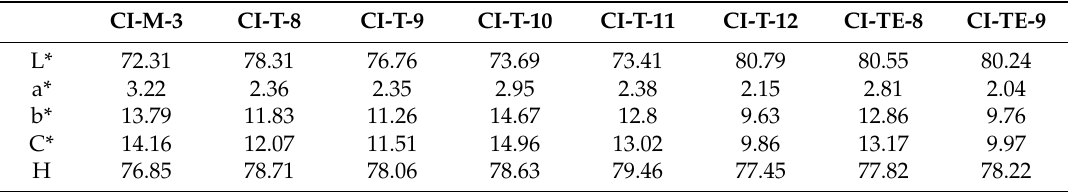
Table 6. Chromatic parameters of mortar samples. Lightness (L*), chromatic coordinates (a* and b*), chroma (C*), hue angle